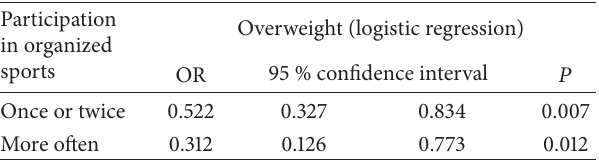
Table 3: Odds ratio (OR) for overweight by participation in organized sports based on logistic regression adjusted for migration and parental weight